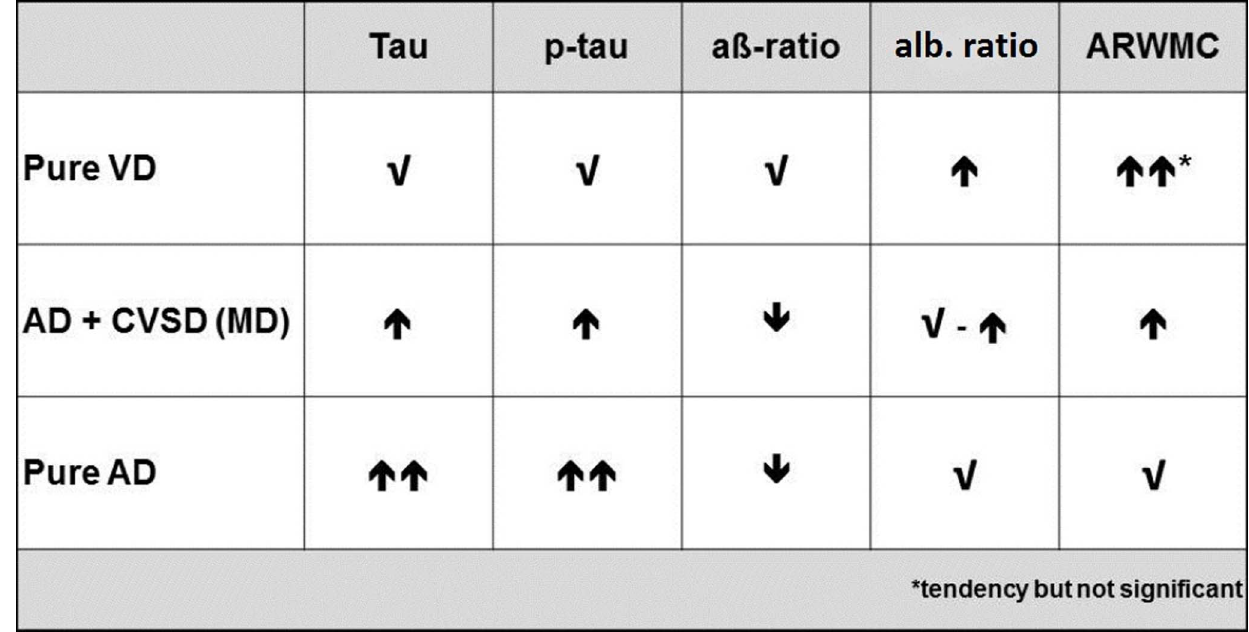
Figure 3. Albumin ratio [CSF/serum] in groups.